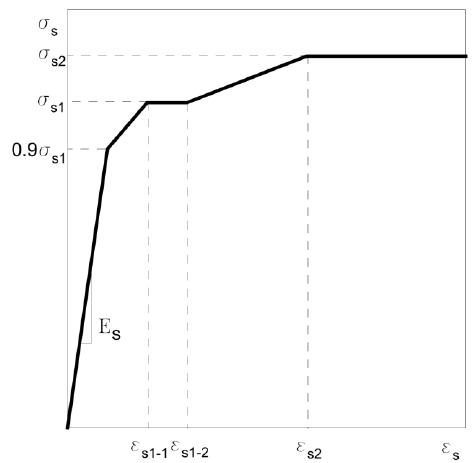
Figure 8. Stress – strain relationship of stainless-steel. Figure 8. Stress–strain relationship of